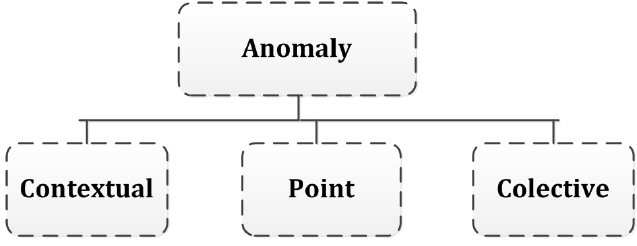
Figure 2. A simple taxonomy of